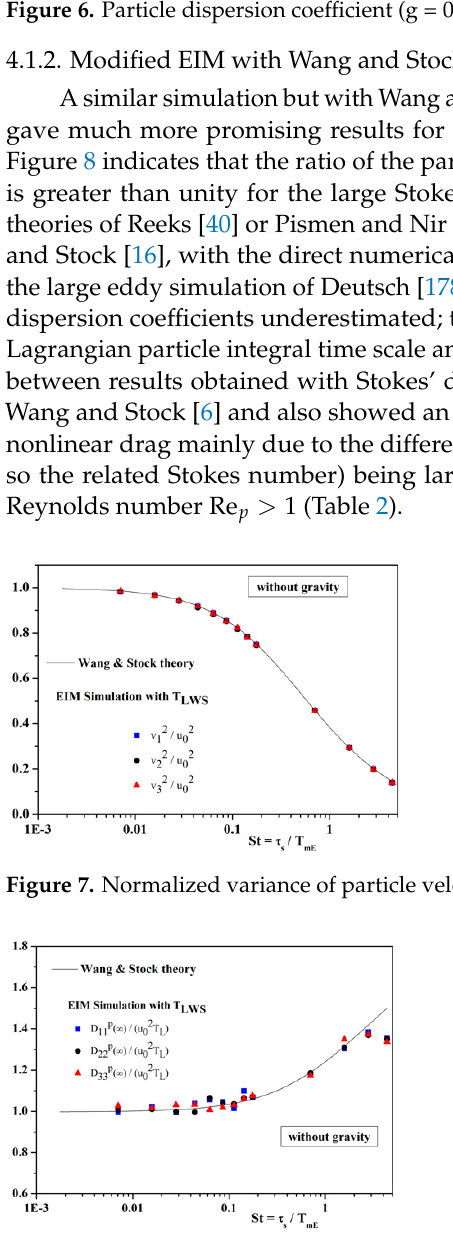
Figure 6. Particle dispersion coefficient (g = 0).